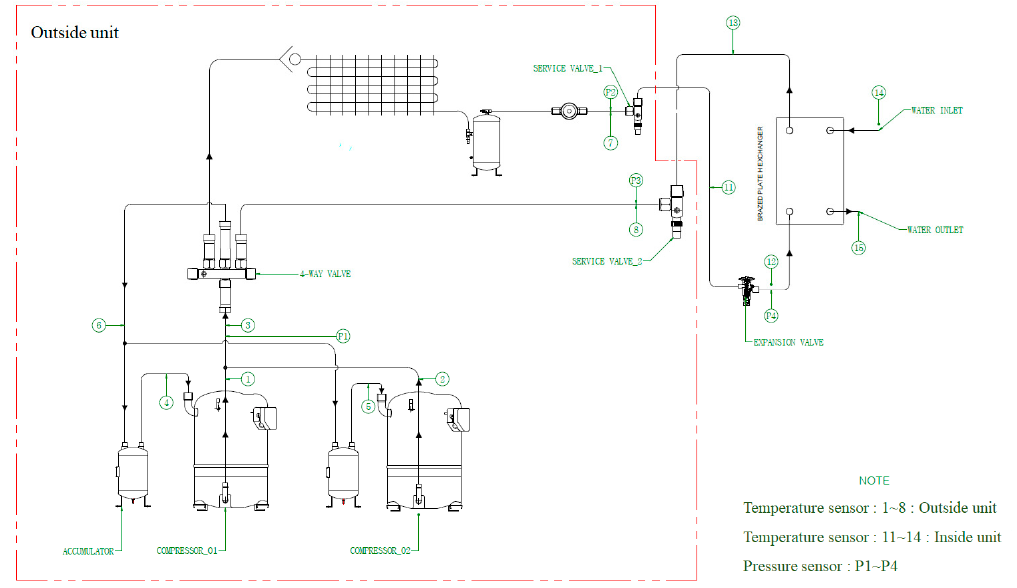
Figure 2. Diagram of heat pump system and sensor.